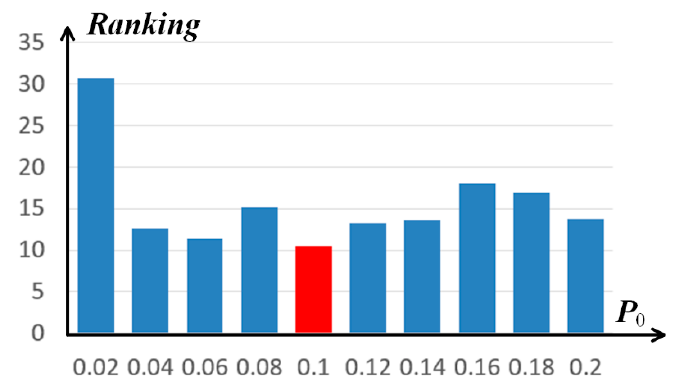
Figure 7. Ranking with various P 0 on the Fayu temple dataset.